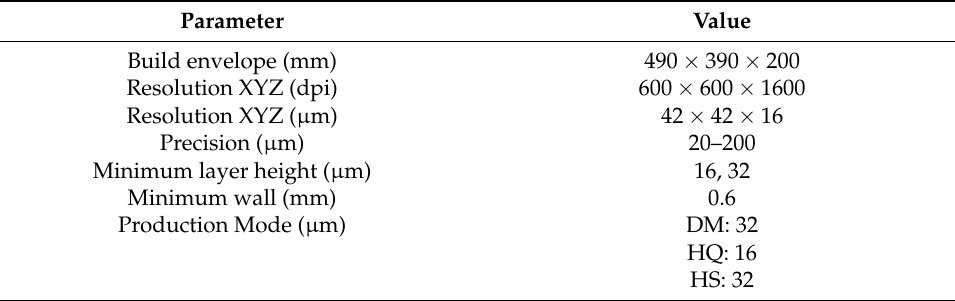
Table 1. Connex3 Objet500™ specifications